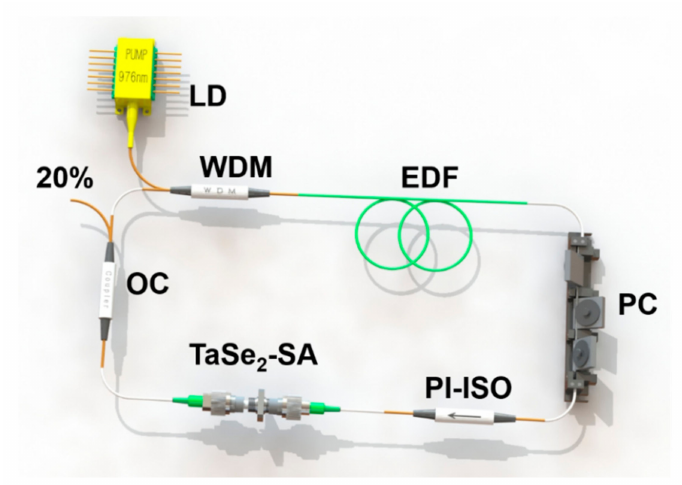
Figure 6. Experimental setup of the Q-switched fiber